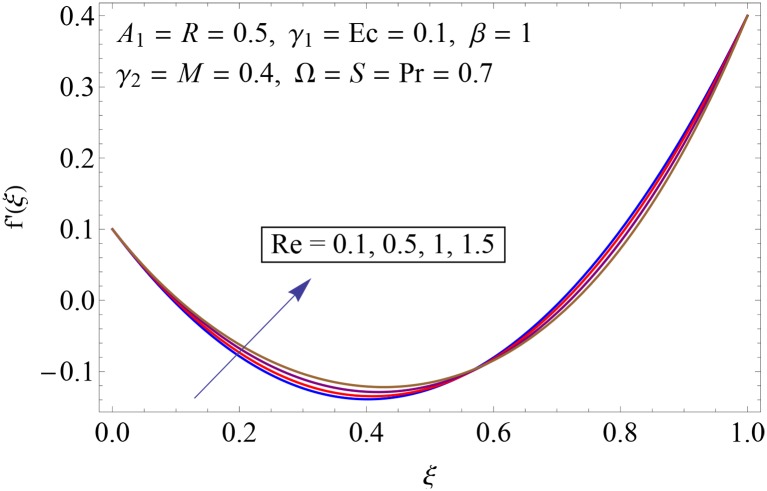
Impact of Re on f′(ξ).